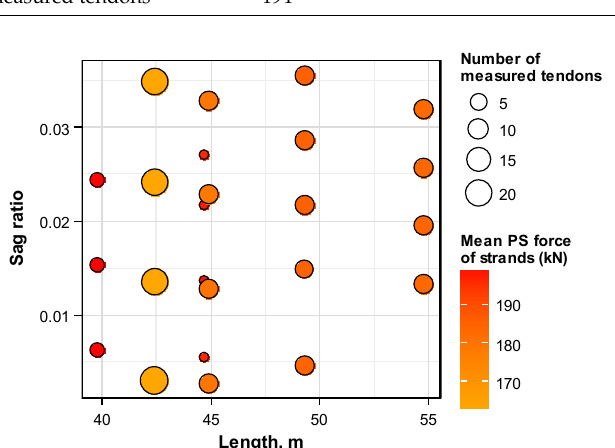
Figure 2. Distribution of considered PSC structures per length and sag ratio.